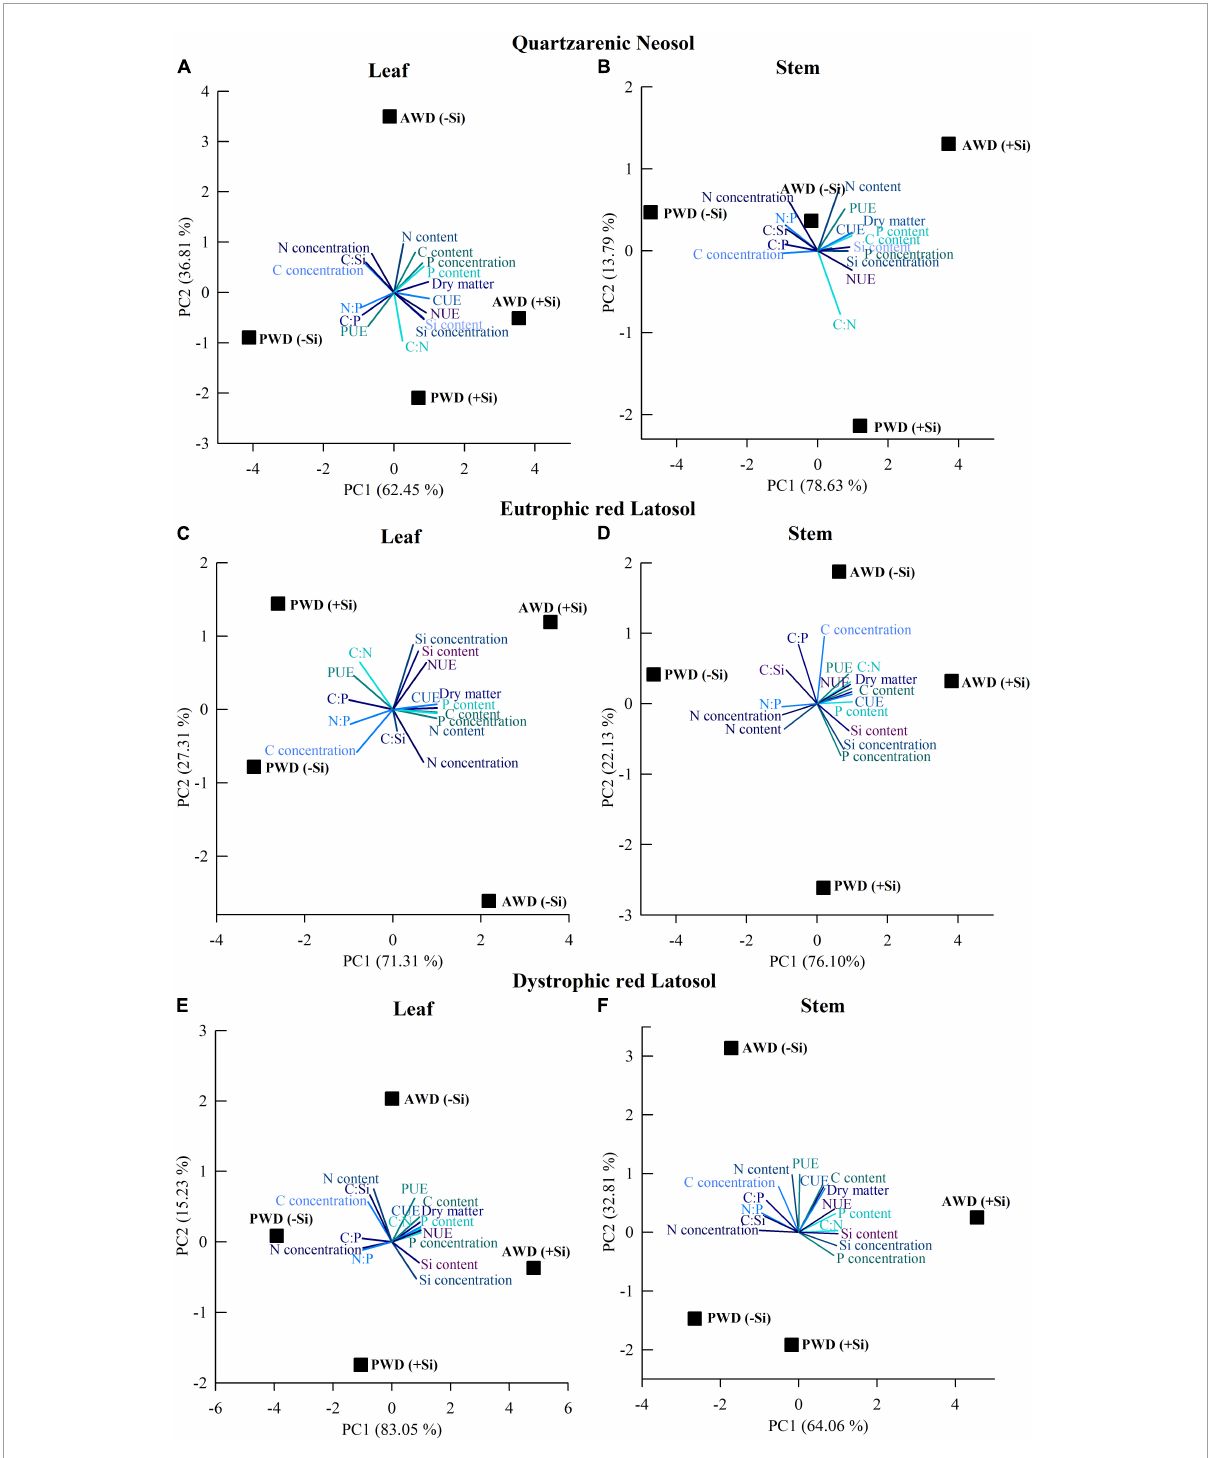
FIGURE7 Principal component analysis of the variables of concentrations and accumulations of C, N, P, and Si, stoichiometric ratios of C:N:P:Si, use efficiencies of C, N, and P, and dry mass partition in the leaf (A,C,E) and in the stem (B,D,F) of sugarcane cultivated with absence (0.0 mM) and presence of fertigated Si (1.8 mM) and two water conditions (without—AWD and with water deficit—PWD) in three tropical soils (Quartzarenic Neosol; Eutroferric Red Latosol; and Dystrophic Red Latosol). CUE, C use efficiency; NUE, N use efficiency; PUE, P efficiency